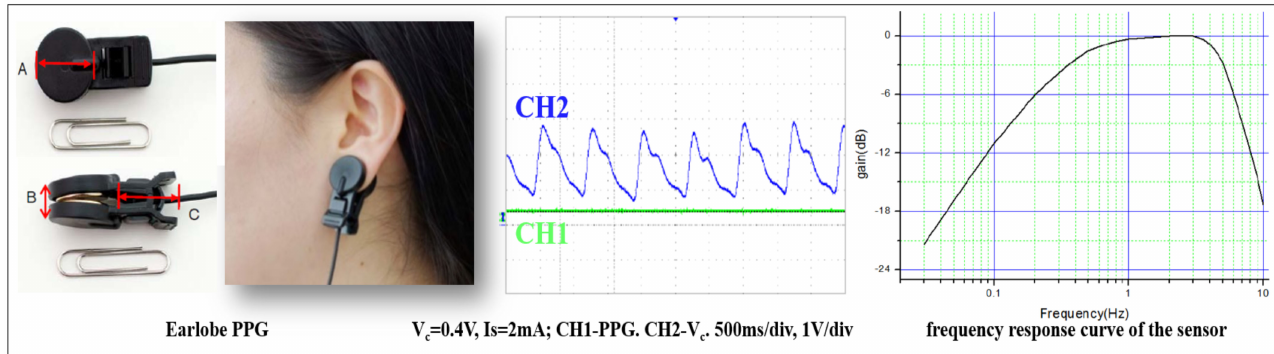
Figure 1. Wearable earlobe type PPG device and